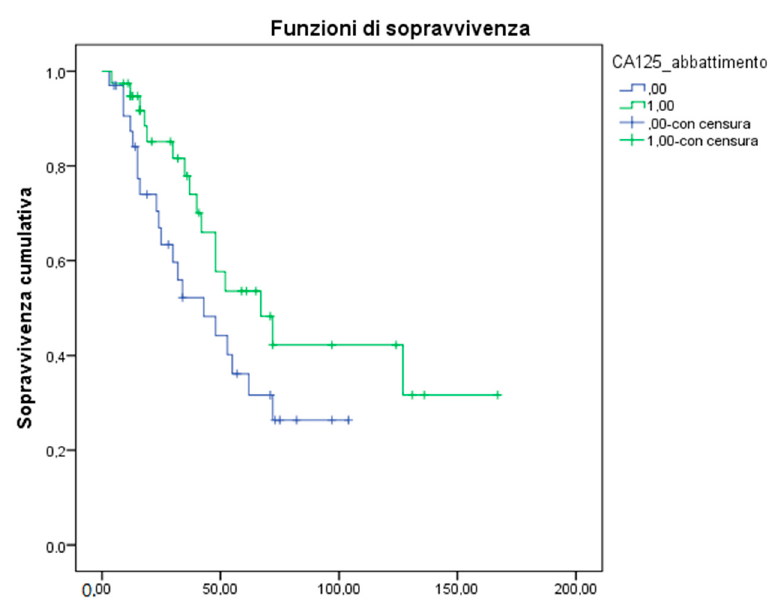
Figure 2. CA 125 decrease in terms of Overall Survival (OS). The median value of basal CA 125 was